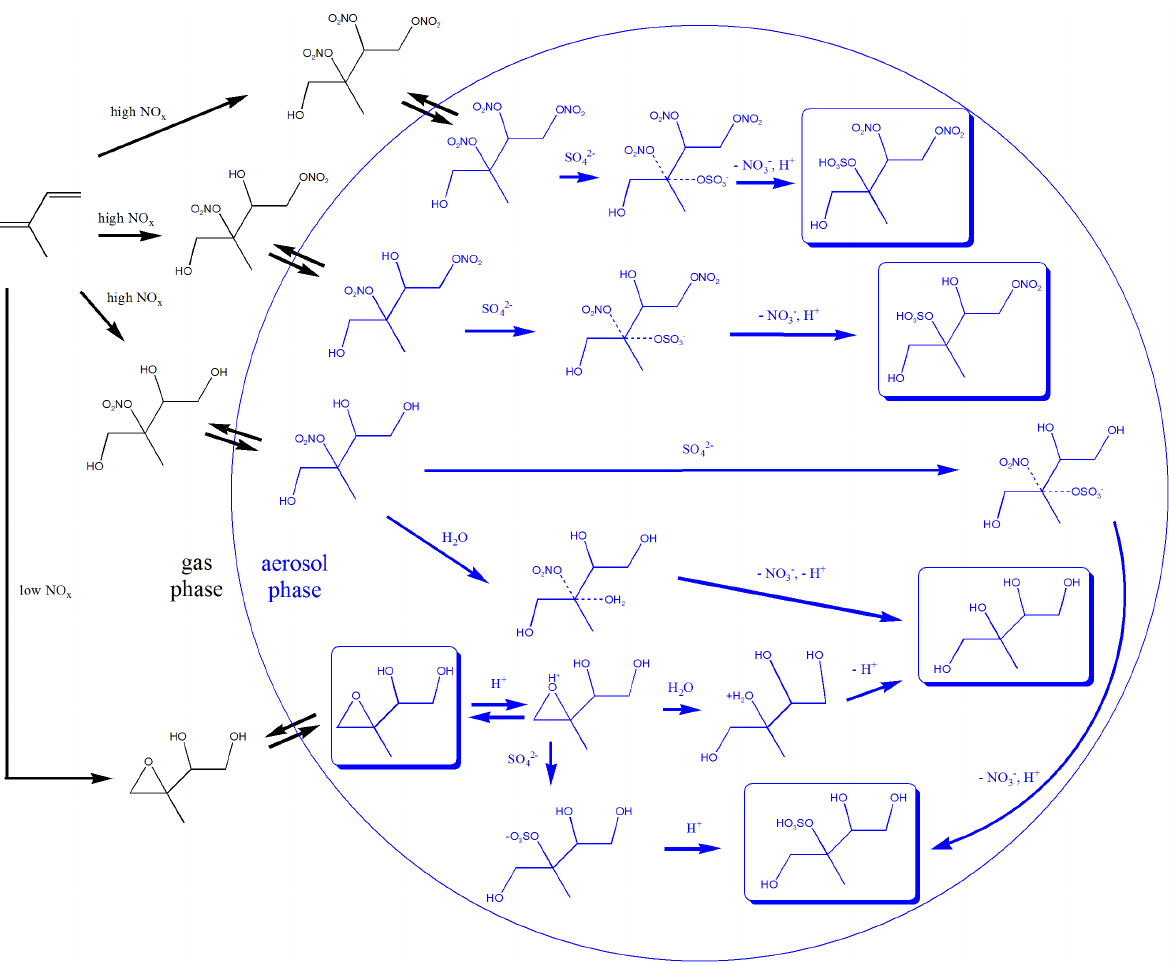
Fig. 1. Proposed mechanism for the formation of several isoprene-derived compounds observed in ambient SOA (enclosed by boxes). 3 ROSO 3 H + H 2 O → H + ROH + H 2 SO 4